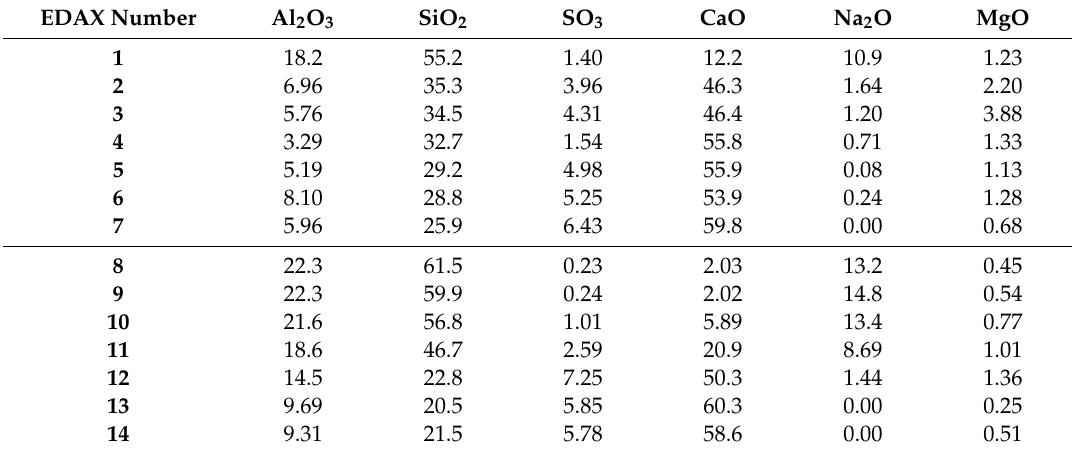
Figure 4. BSEM images of the additive particles and the gel surrounding them in Add1 concrete. Left: × 2500; right: × 4000. The numbers show the exact position of the EDAX shown in Table 6. Table 6. EDAX microanalysis specified in the BSEM images of Figure 4 (main oxides, wt.%); Add1